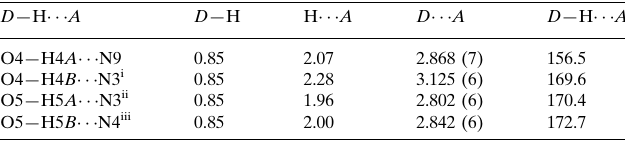
Hydrogen-bond geometry (A˚ , (cid:3) ). D —H (cid:2)(cid:2)(cid:2)